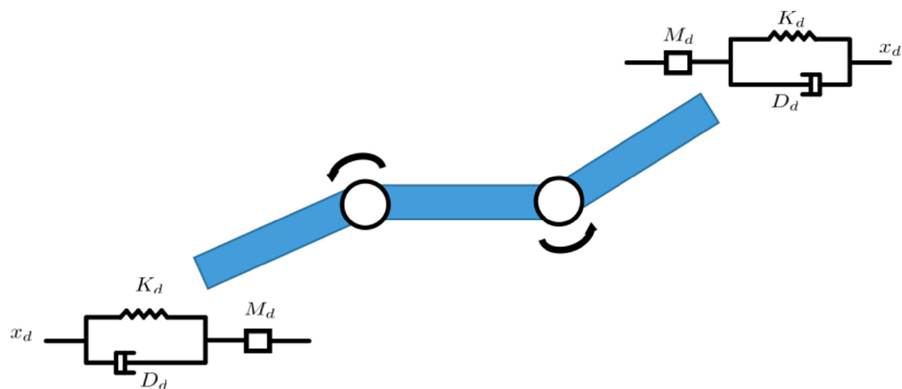
Figure 12. The structure modeling and the impedance control illustration of the baby chair.